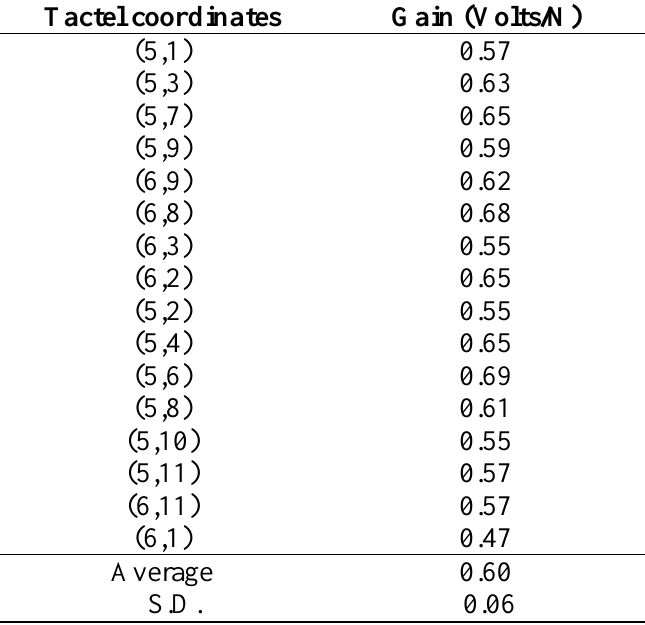
Table 2. Variations of Tactels.